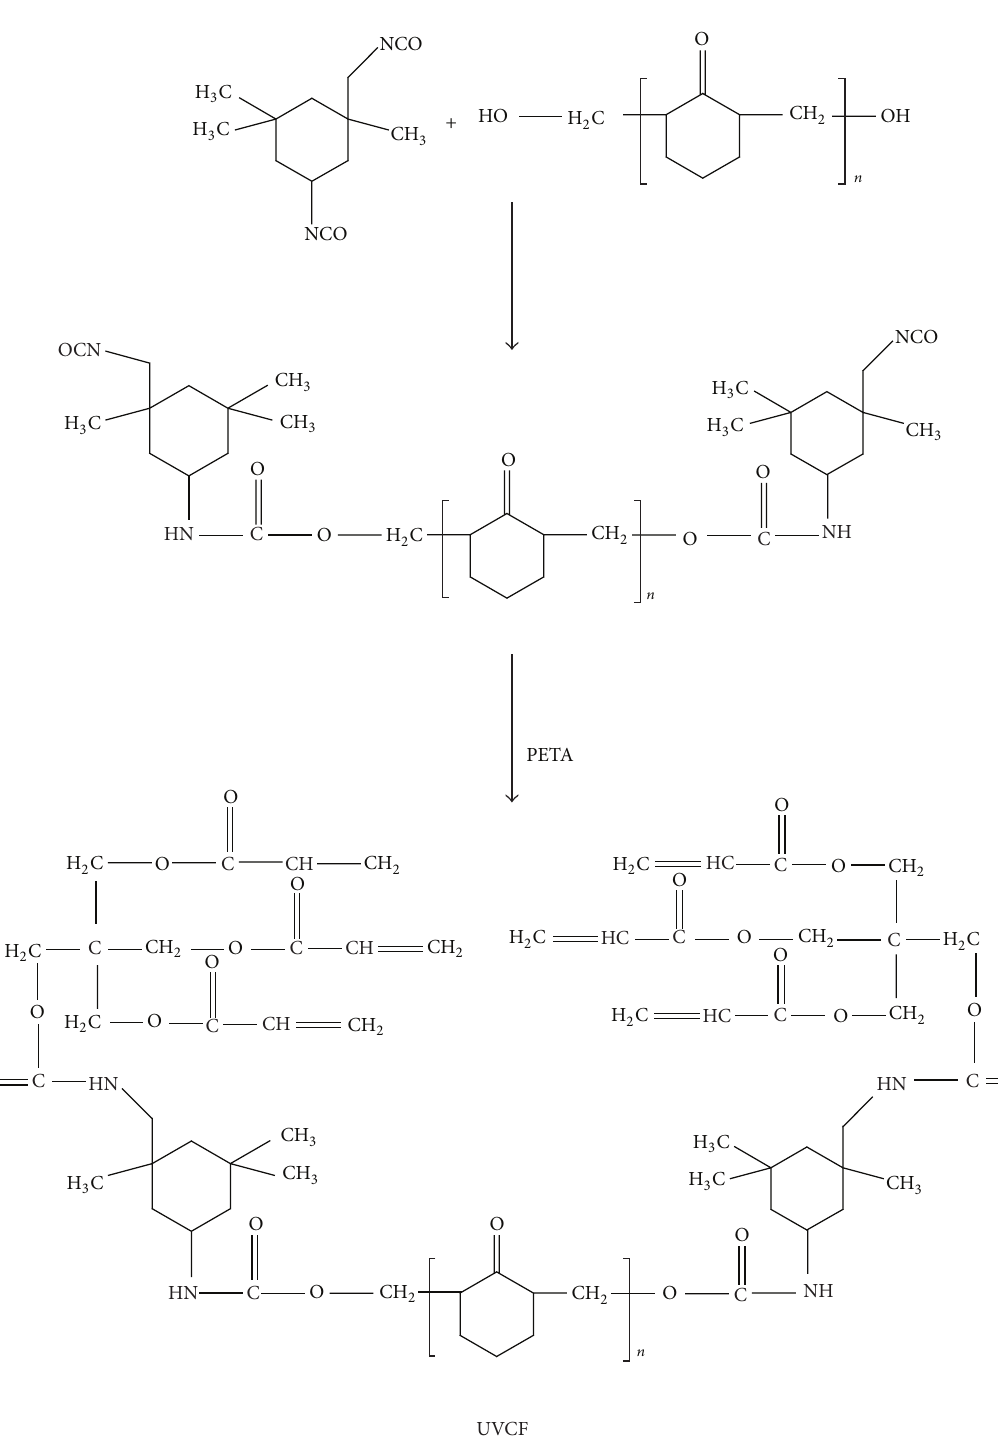
Figure 1: Schematic illustration for the synthesis of